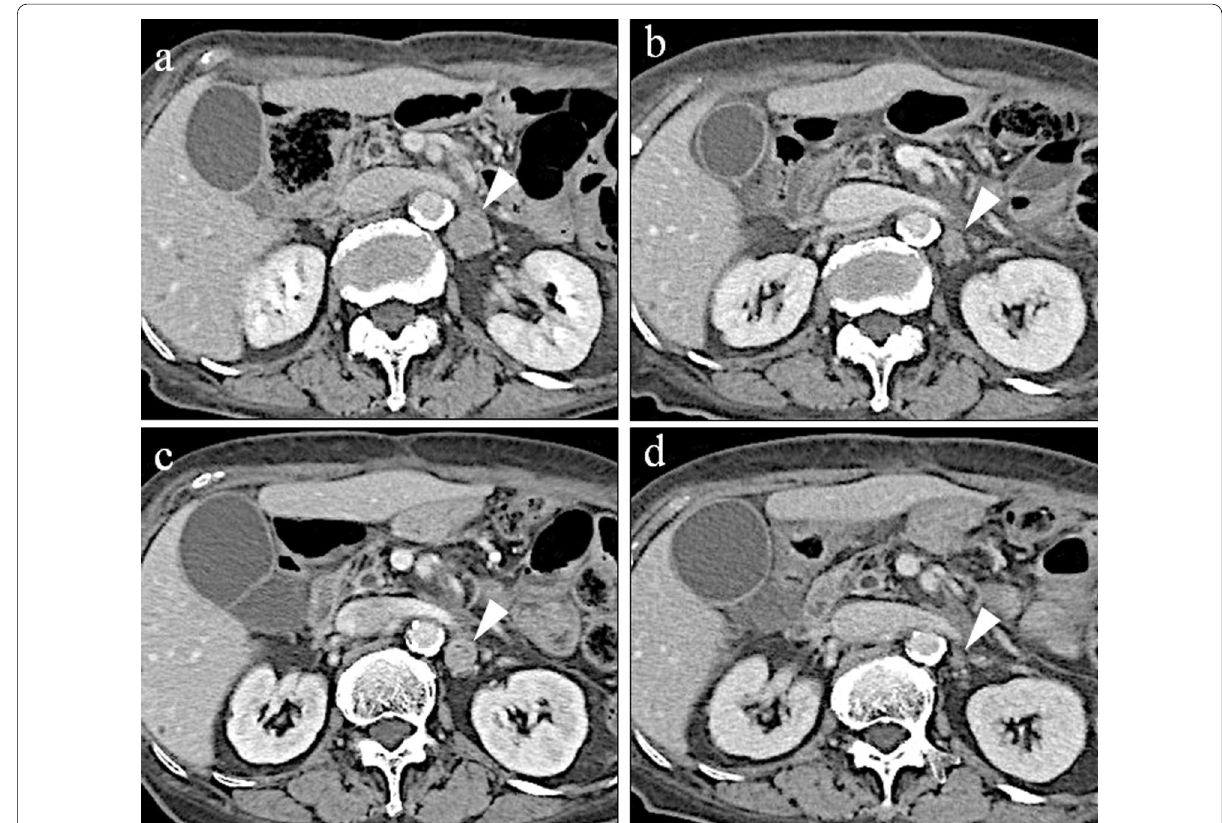
Fig. 4 a Recurrent No. 16b1 enlarged to 20.1 mm after SOX therapy. b Lesion shrank to 15.6 mm after three courses of RAM enlarged to 18.1 mm during the first RAM withdrawal period. d Lesion again shrank to 10.5 mm with resuming RAM